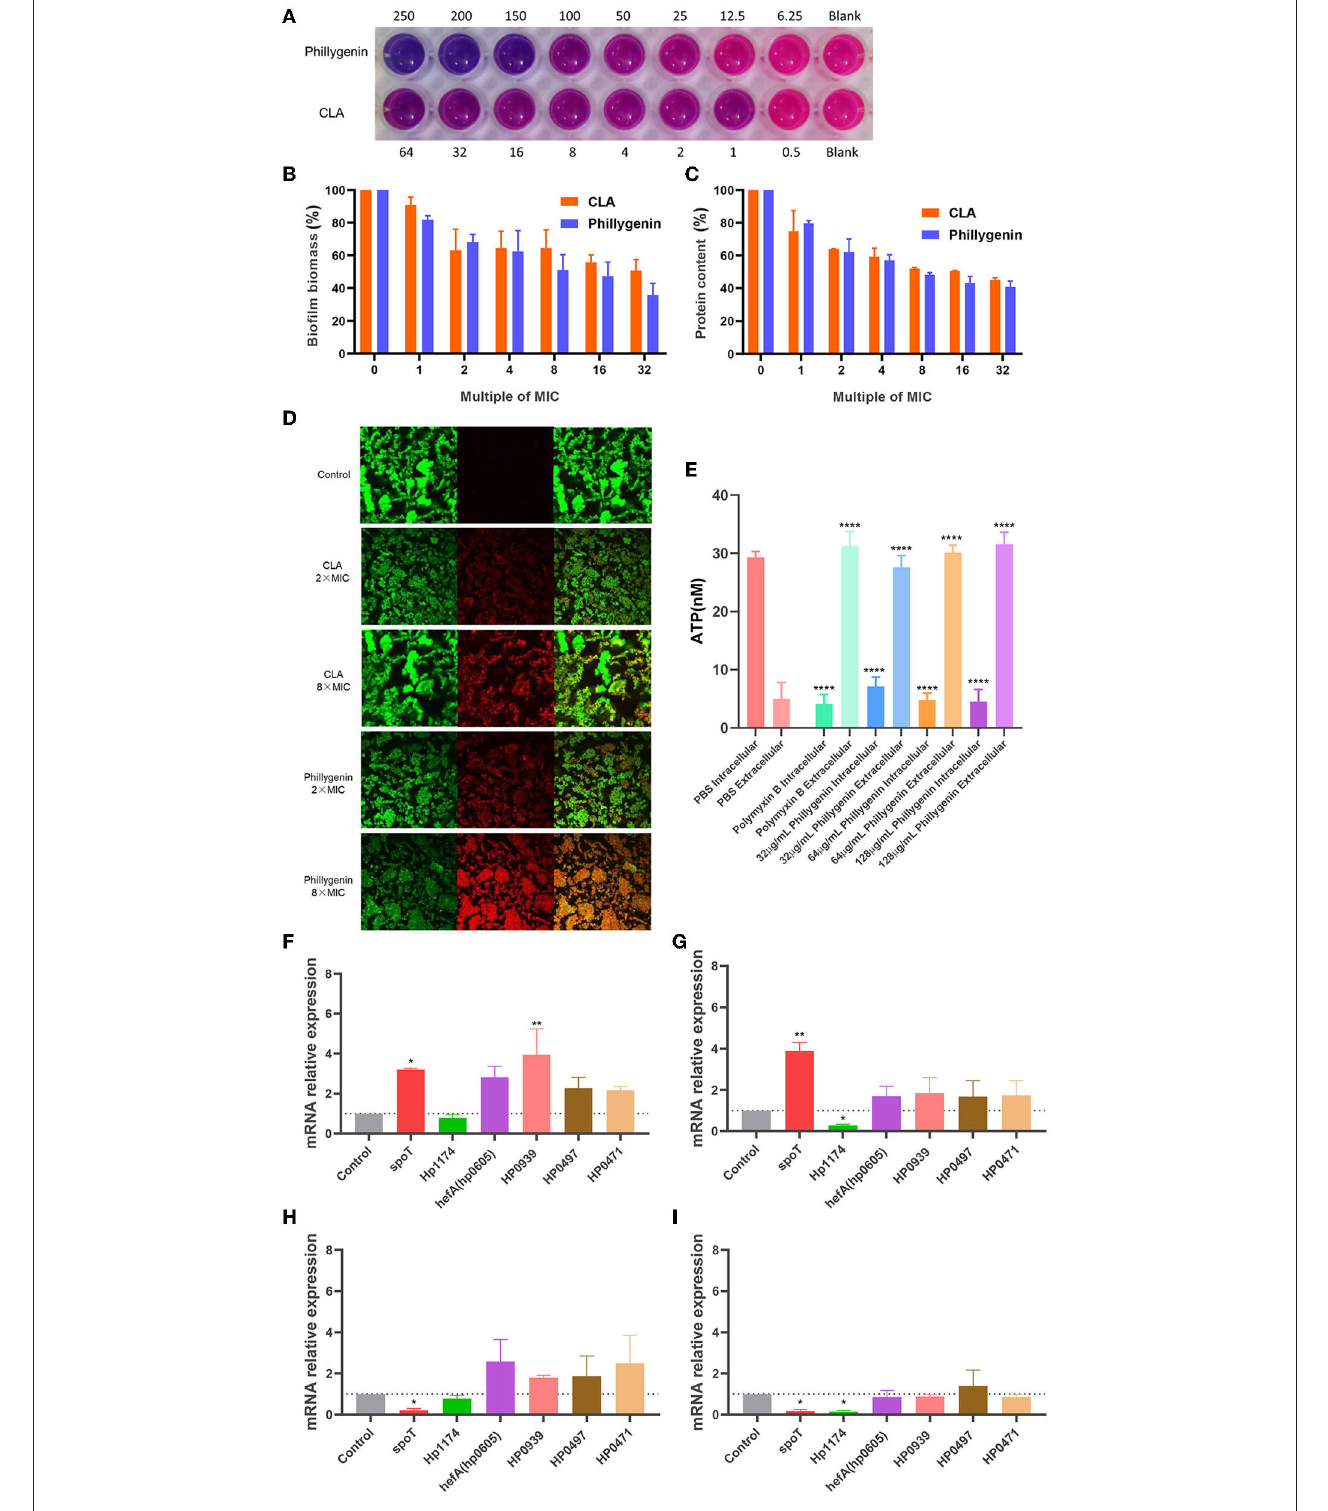
FIGURE 6 | The inhibitory effect of phillygenin on biofilms and adenosine triphosphate (ATP). (A) The detection of the inhibition of biofilms using the Alamar blue assay; (B) the detection of biofilm expression levels through the crystal violet staining; (C) the expression levels of biofilm protein; (D) the detection of biofilm through the confocal laser scanning microscopy at a 400 magnification; (E) ATP detection; (F) the changes in the relative expression quantity of the mRNA of biofilm-related genes in suspended bacteria treated with phillygenin at a concentration of two times of the MIC; (G) the changes in the relative expression quantity of the mRNA of genes in